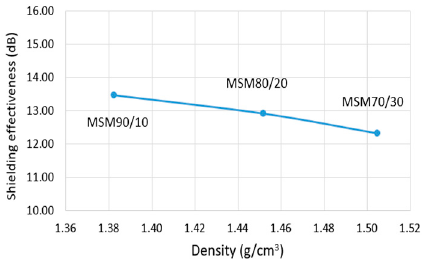
Figure 25. SE dependence of density. Iron scale mix of flakes and powder. Frequency—10 GHz.